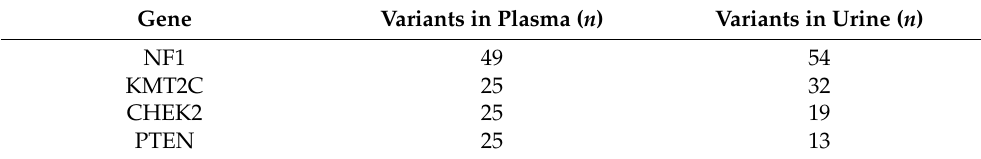
Table 3. Number of pathogenic/likely pathogenic variants per gene found in plasma and urinary ctDNA. Gene Variants in Plasma ( n ) Variants in Urine ( n ) NF1 49 54 KMT2C 25 32 CHEK2 25 19 PTEN 25